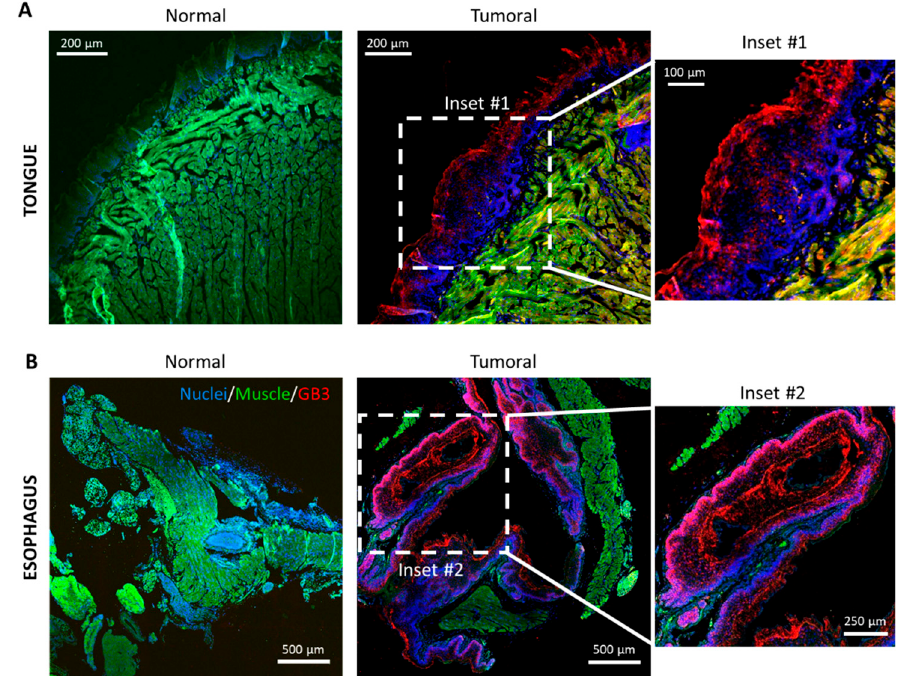
Figure 2. GB3 expression in an HNC mouse model. Multichannel confocal microscopy images of sections of murine ( A ) tongues and ( B ) esophagus. Sections were immunostained with Alexa647- anti-CD77 (red channel). Nuclei were stained with Dapi (blue channel) and the autofluorescence of the muscle fibers appear in the green channel. The red color is indicative of GB3 expression. Scale bars = 500, 250 μ m.